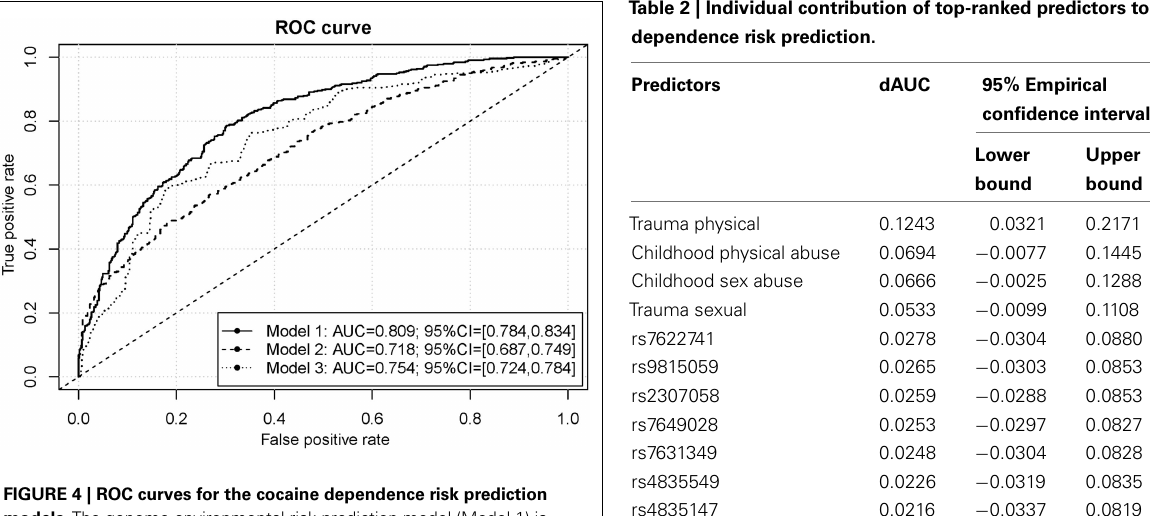
FIGURE 4 | ROC curves for the cocaine dependence risk prediction models. The genome-environmental risk-prediction model (Model 1) is comprised of 330 SNPs and 9 facets of environment, while the genome-wide risk-prediction model (Model 2) is comprised of only 330 SNPs and the environmental risk-prediction model (Model 3) is comprised of the 9 facets of environment.